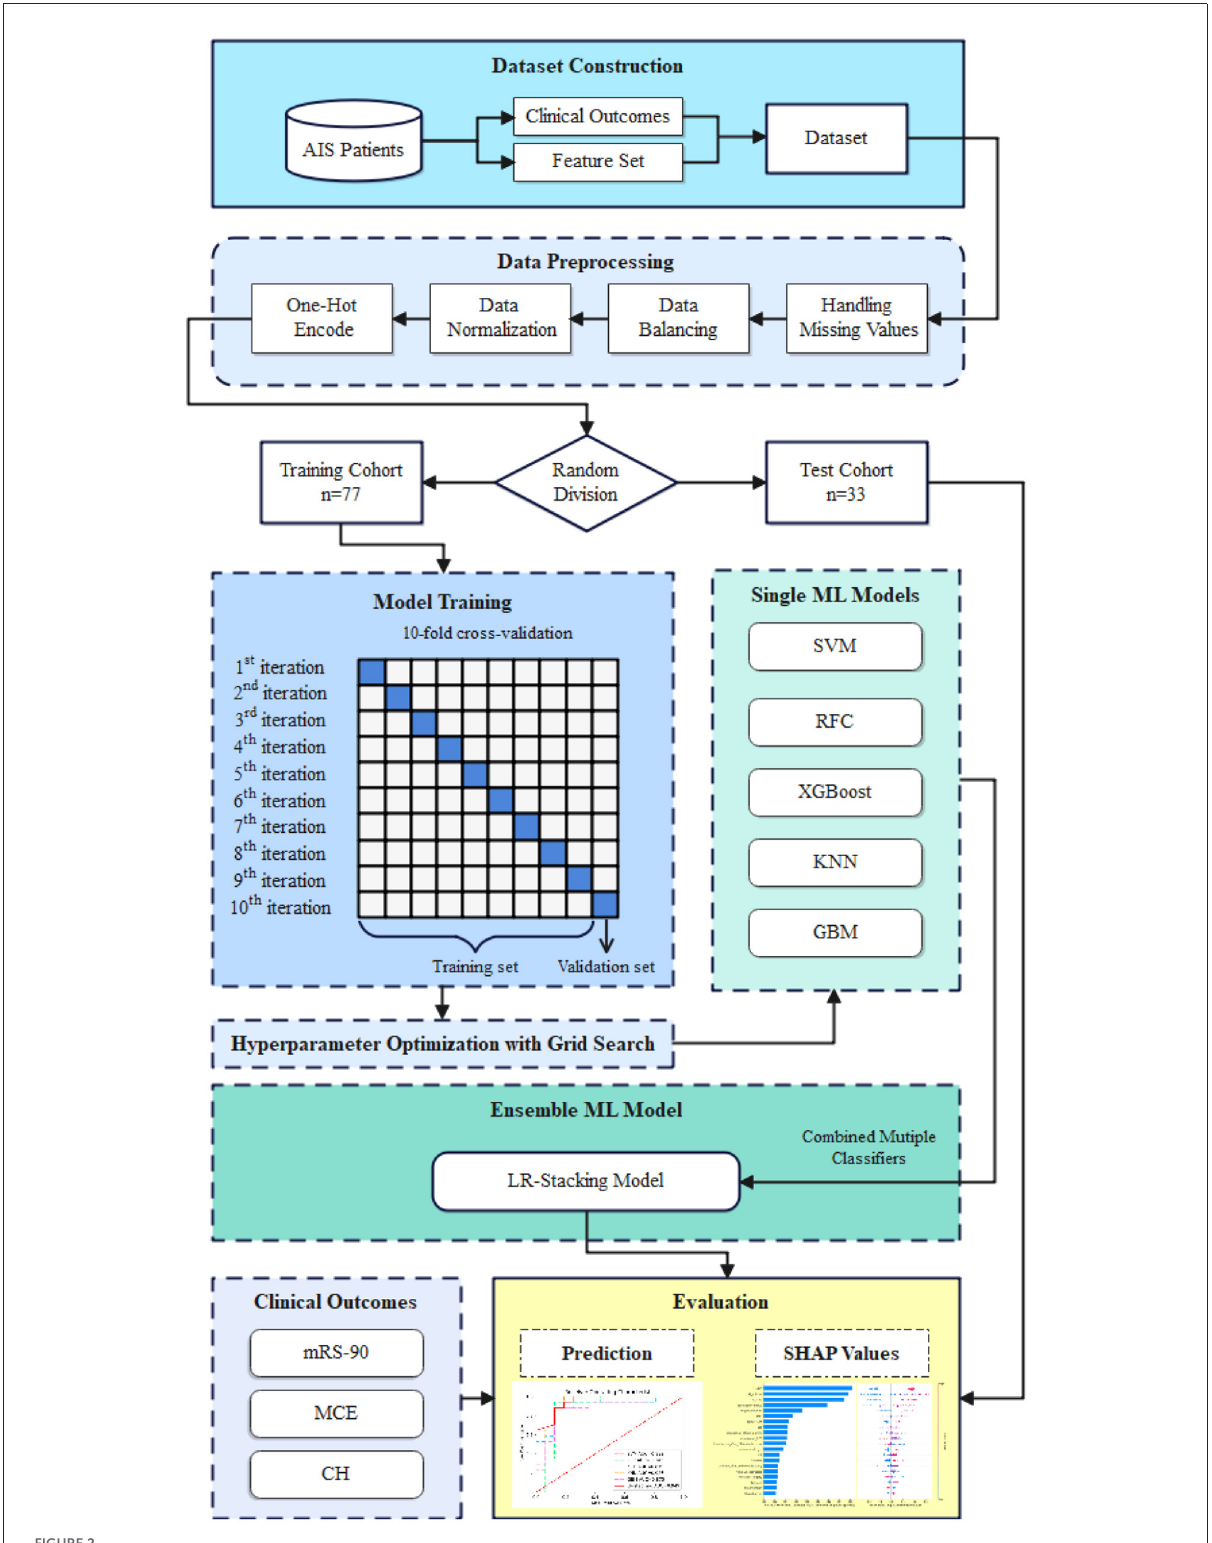
FIGURE2 The model development pipeline. First, data were randomly divided into training and test sets without duplication. Next, using the training set, the five basic ML algorithms were internally trained, and their predictive ability was validated by applying a 10-fold cross-validation and hyperparameter optimization using the grid search method. Subsequently, the basic ML models were integrated into the LR-Stacking model, and the optimal model was evaluated in test